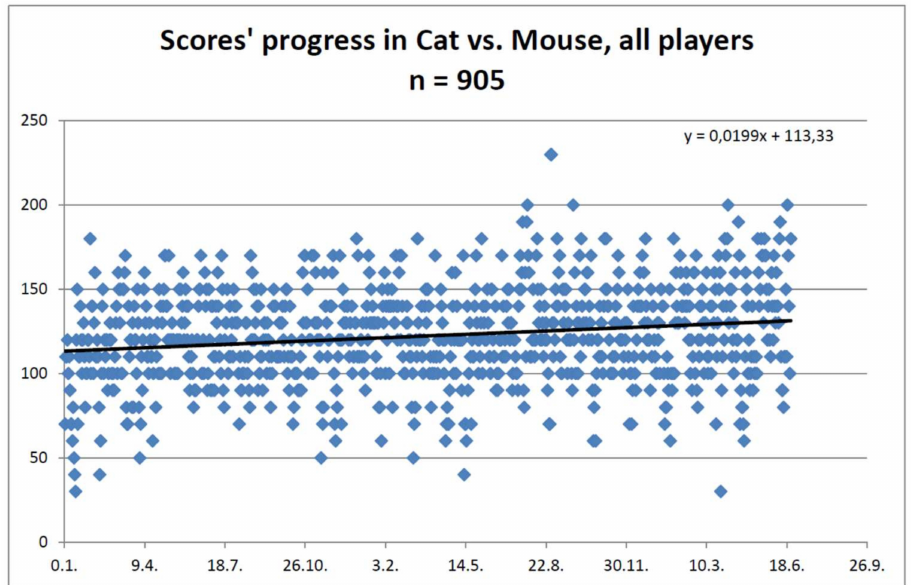
Figure 5. Cat vs. Mouse game scores in China ( y -axis illustrates game score and x -axis the dates).